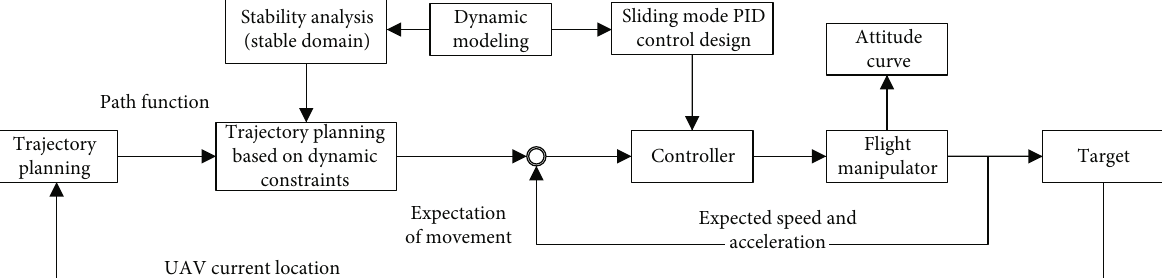
Figure 2: Control process.